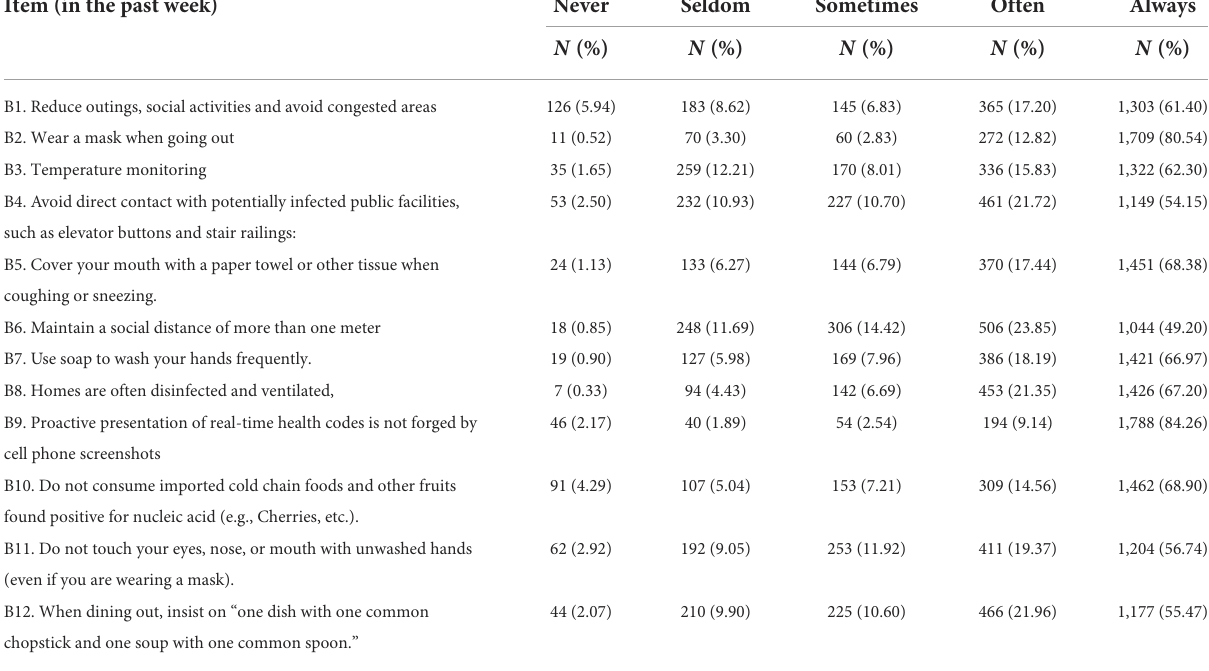
TABLE 5 Level of preventive behavior for COVID-19 ( N = 2,122). Item (in the past week) Never Seldom Sometimes